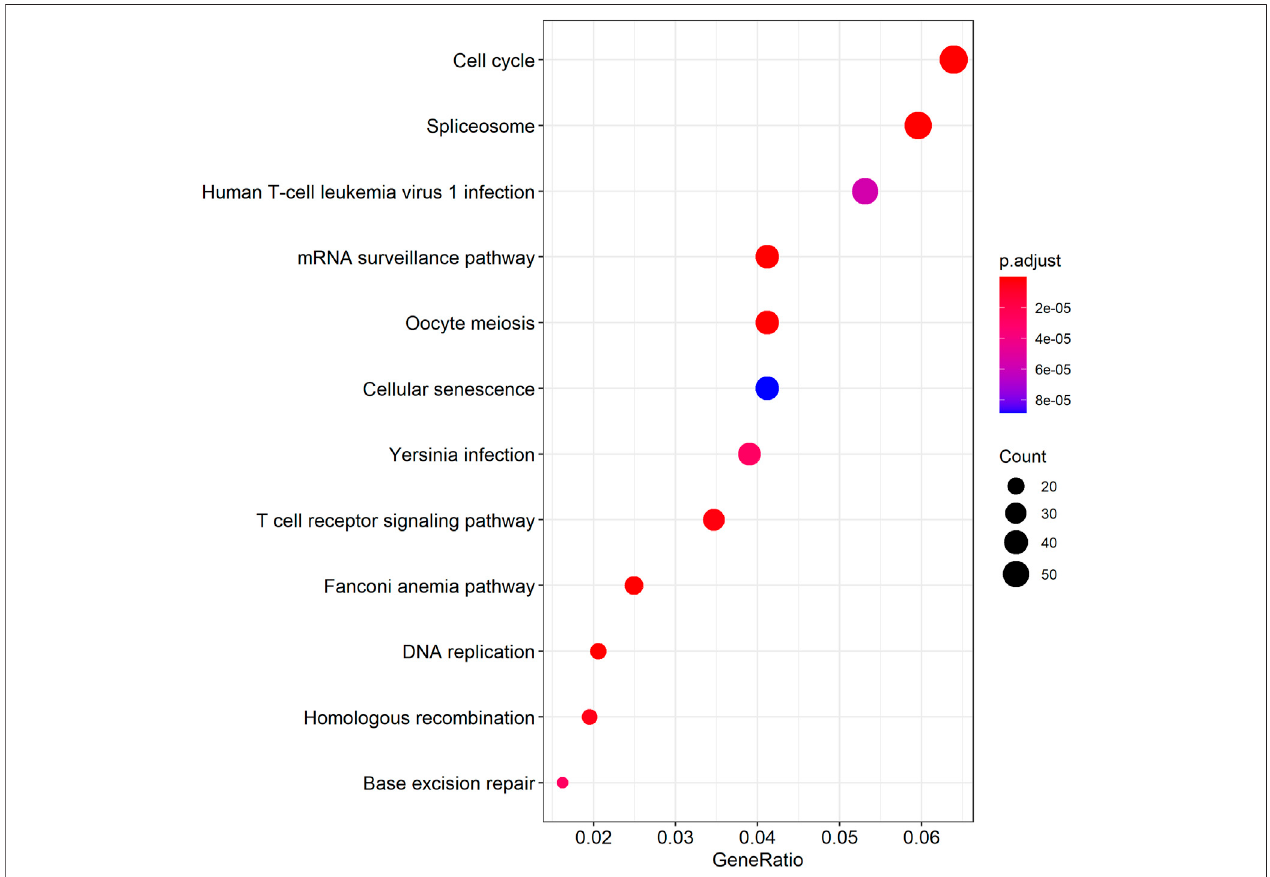
FIGURE 8 | KEGG analysis of AC004943.1 target genes. Note: The target genes of lncRNAs were identi fi ed from Pearson ’ s correlation analysis (|correlation coef fi cient| > 0.4 and p < 0.001), KEGG analysis were performed in “ clusterPro fi ler ” and “ DOSE ” of R software to generated these functional pathways.